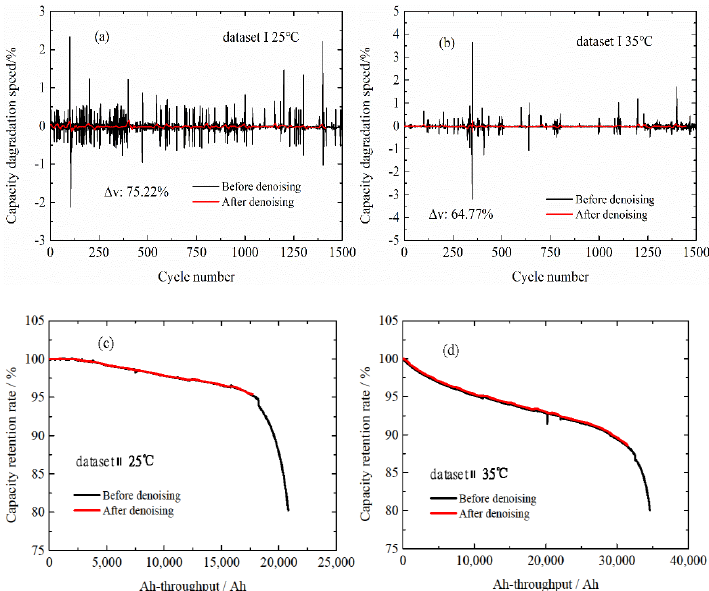
Figure 3. The denoising results with the wavelet transform: the per-cycle degradation speed of Dataset Ⅰ at ( a ) 25 °C and ( b ) 35 °C; the removal of the capacity drop of Dataset Ⅱ at ( c ) 25 °C and ( d ) 35 °C.